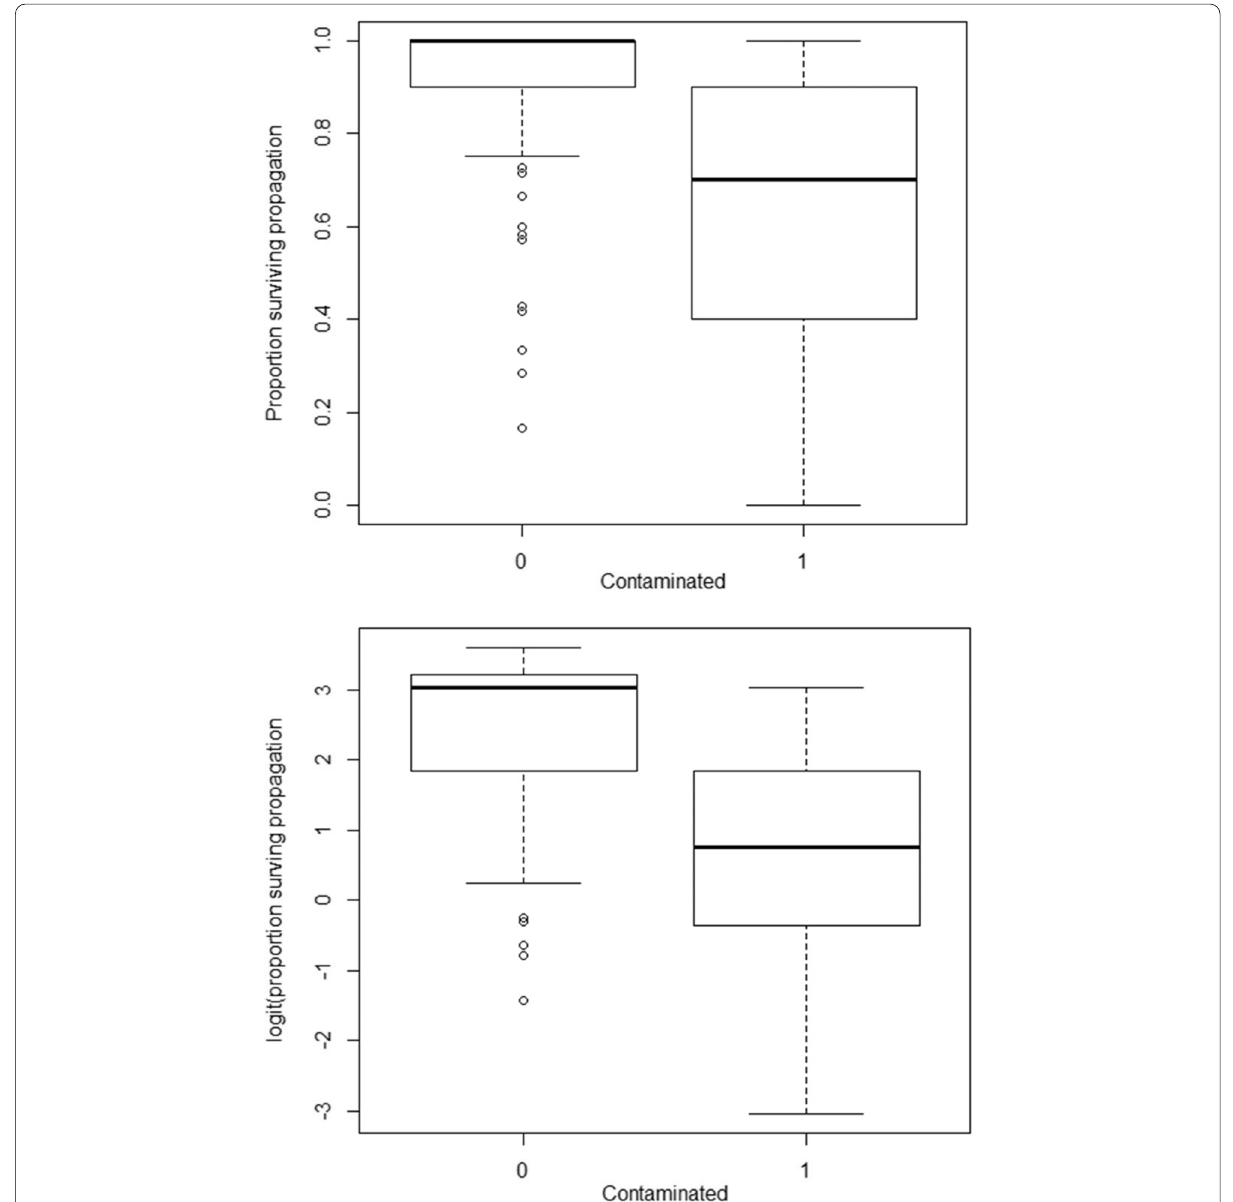
Fig. 6 The proportion of plantlets surviving the in vitro rooting stage, is affected by whether they were contaminated or not, by B. megaterium / B. aryabhattai . The left-hand picture shows raw proportions, the right-hand picture shows logit transformed proportions which account for the data being bounded by 0 and 1. Almost all uncontaminated seedlings survived, while a considerably lower proportion of the uncontaminated seedlings